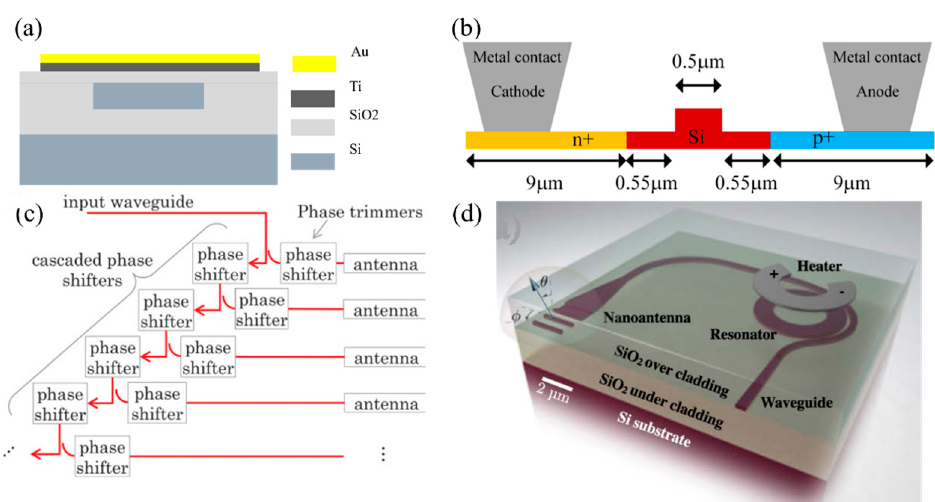
Figure 6. ( a ) Cross section of a TO phase shifter. ( b ) A p-i-n junction-based EO phase shifter for OPAs. Reprinted with permission from [43] © The Optical Society. ( c ) Simplified schematic of a cascaded-shifters-based OPA. Reprinted with permission from [99] © The Optical Society. ( d ) A compact spiral phase shifter. Reprinted with permission from [100] © The Optical Society.